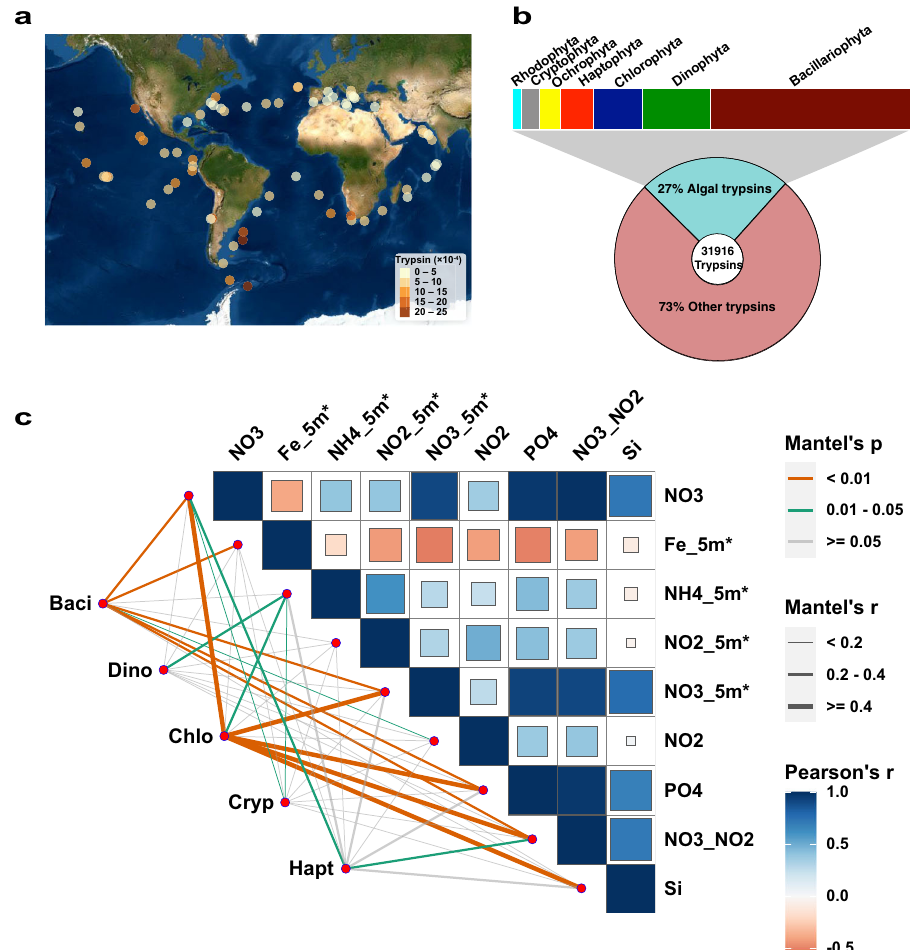
Fig. 1 Widespread occurrence and environmental nutrient responsiveness of trypsin in global marine phytoplankton. a Wide geographic distribution of trypsin in phytoplankton found in Tara Oceans. Color scale depicts trypsin mRNA abundance. b Wide taxonomic distribution of trypsin in algae found in PhyloDB. c Environmental nutrient drivers of phytoplankton trypsin abundance. Pairwise comparisons of environmental nutrient concentrations are shown with a color gradient denoting Pearson ’ s correlation coef fi cient. The trypsin abundance and taxonomic distribution based on the 5 – 180 µ m size fraction from SRF layer from Tara Ocean datasets. Taxonomic trypsin abundance was related to each nutrient factor by partial (geographic distance-corrected) Mantel tests. Edge width corresponds to the Mantel ’ s r statistic for the corresponding distance correlations, and edge color denotes the statistical signi fi cance based on 9999 permutations. Baci Bacillariophyta, Dino Dinophyta, Chlo Chlorophyta, Cryp Cryptophyta, Hapt Haptophyta. Source data are provided as a Source Data fi